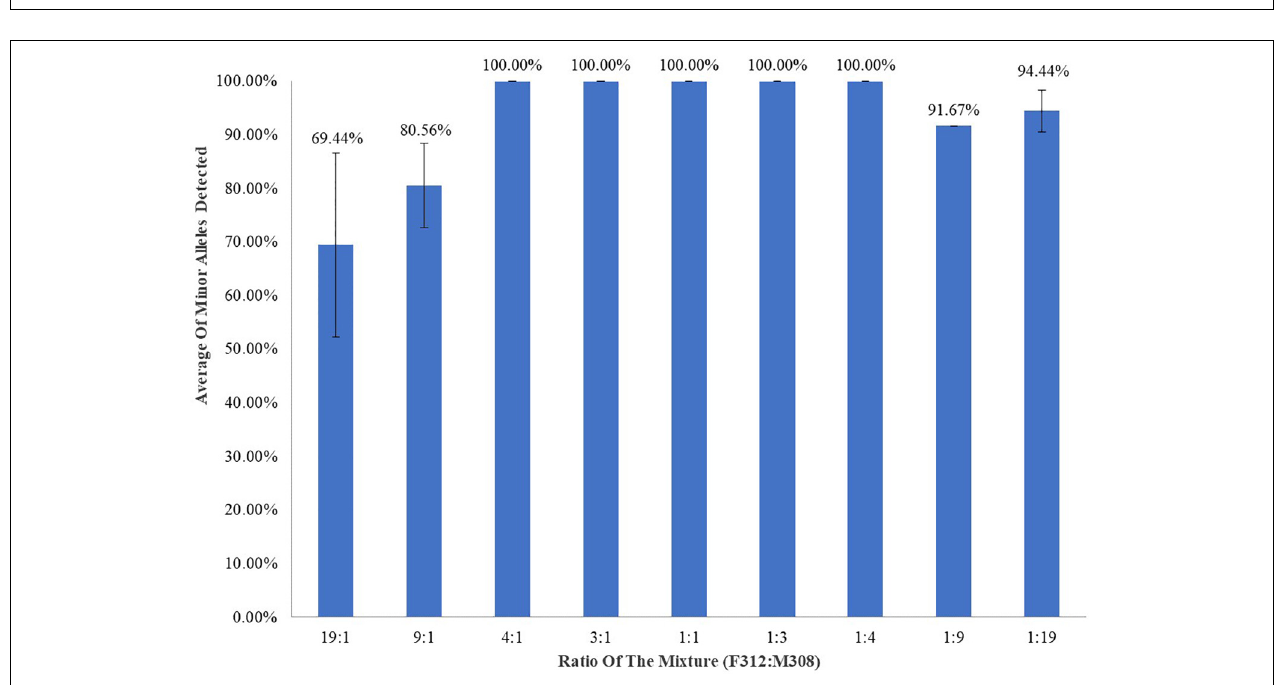
FIGURE 2 | Results of a sensitivity study using serially diluted control DNA F312. Green boxes, no allele drop-out; red boxes, no alleles recovered; yellow boxes, only one of two expected heterozygote alleles was called.